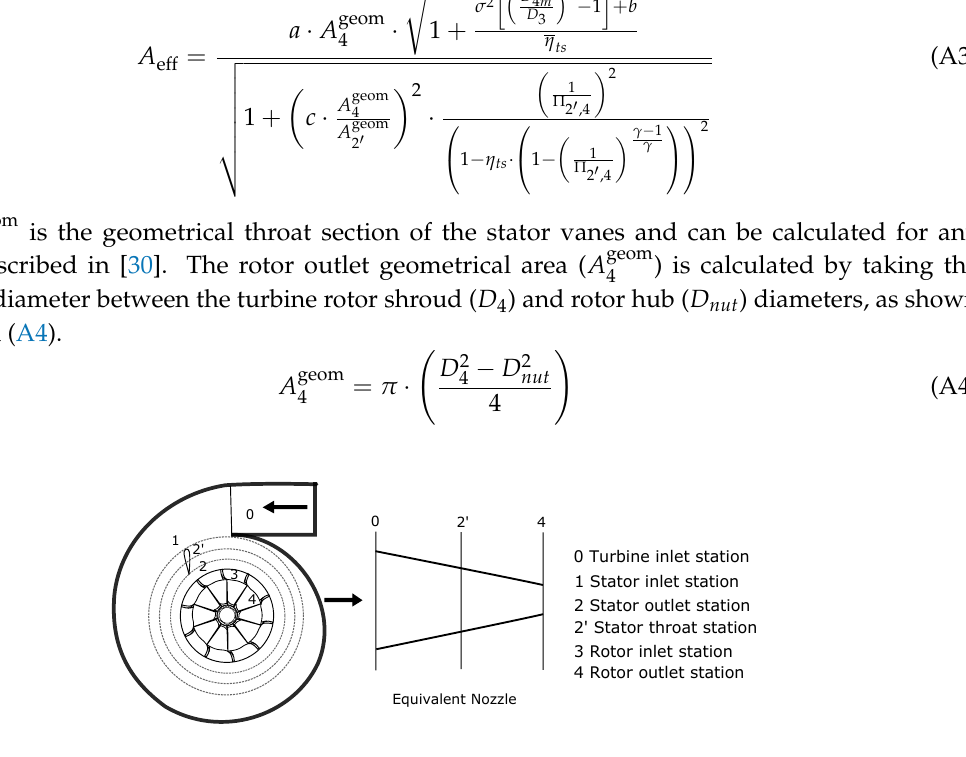
Figure A1. Turbine as single equivalent nozzle and stations